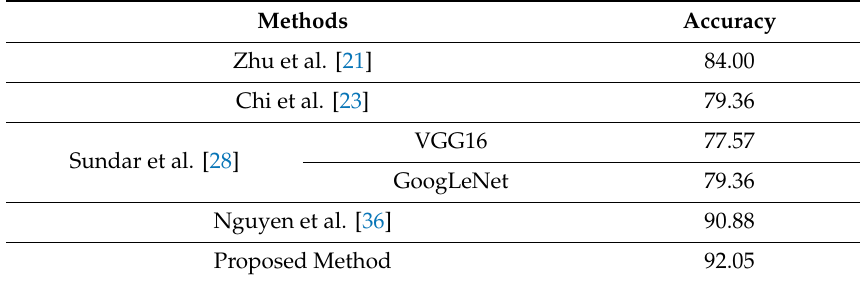
Table 9. Comparison of the overall accuracy of the previous studies and our proposed method with the TDID dataset (unit: